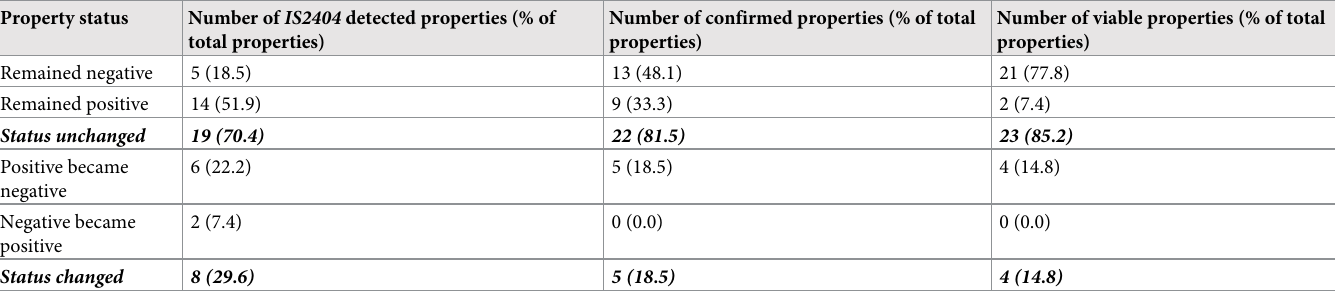
Table 4. Property status between first and second field surveys by assay type. Property